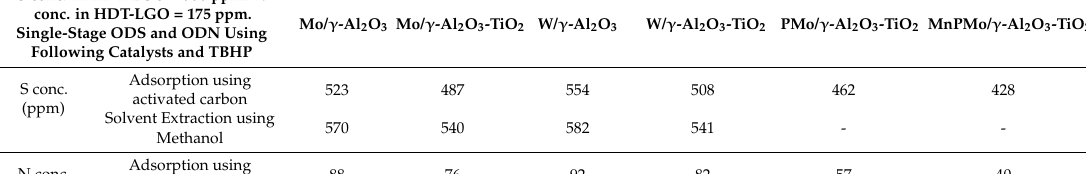
Table 4. Oxidative desulfurization and denitrogenation of hydrotreated light gas oil. (error ± 4 ppm). S conc. in HDT-LGO = 950 ppm. N conc. in HDT-LGO = 175 ppm. Single-Stage ODS and ODN Using Following Catalysts and